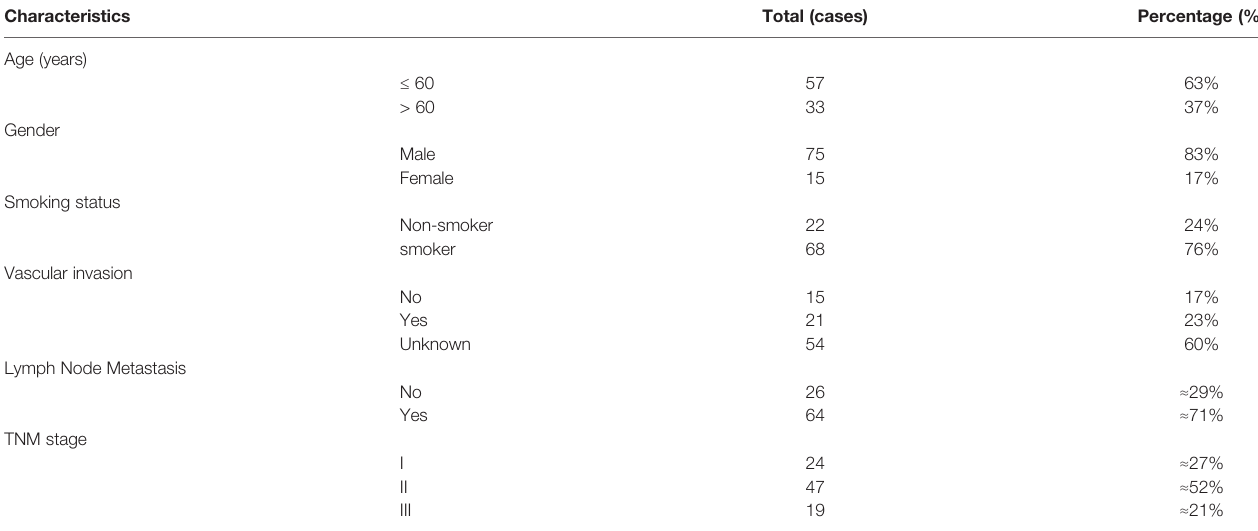
TABLE 1 | Clinical characteristics of 90 SCLC